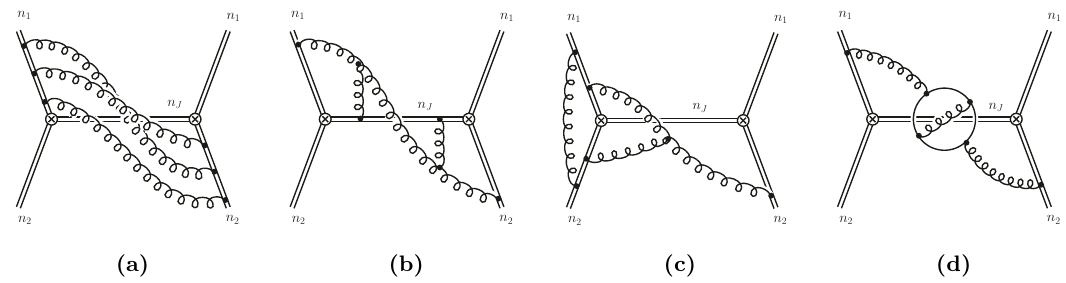
Figure 3. Examples for three-loop Feynman diagrams that contribute to the soft function S ( ω ) . ω + i0 → ω )